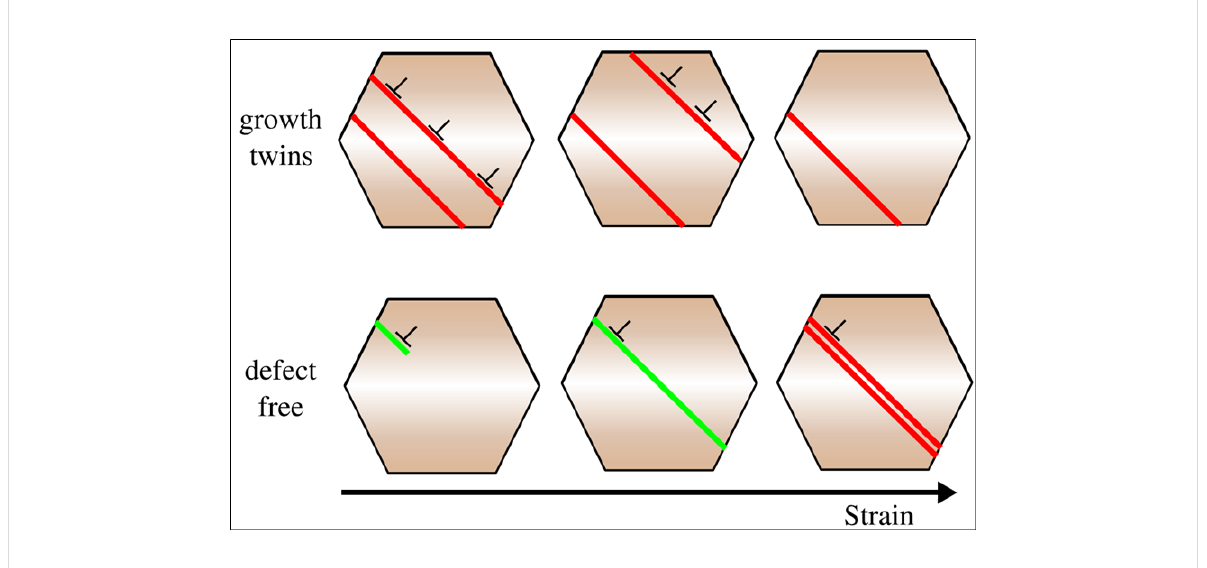
Figure 8: Model of the deformation pathways: If growth twins are initially present, partial dislocations nucleate at twin boundaries and lead to twin boundary migration out of the grain. If the grains are initially defect free, partial dislocations nucleate into a defect free grain and can form stacking faults and twinning faults by successive nucleation of partial